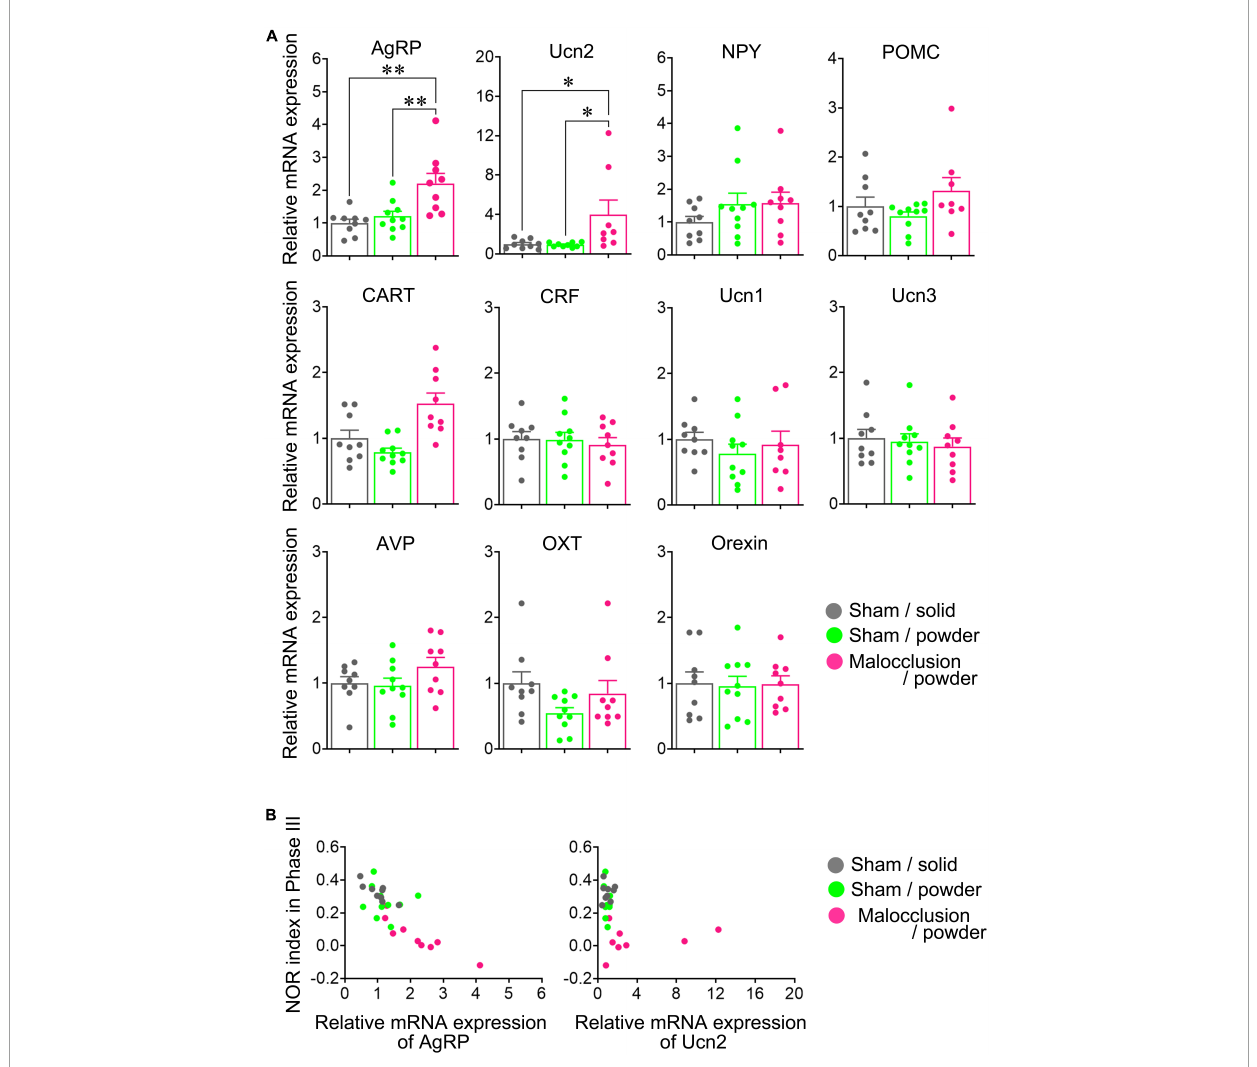
FIGURE3 Hypothalamic neuropeptide mRNA levels. (A) mRNA levels of AgRP, agouti-related peptide; NPY, neuropeptide Y; POMC, proopiomelanocortin; CART, cocaine- and amphetamine-regulated transcript; CRF, corticotropin-releasing factor; Ucn, urocortin 1, Ucn2, Ucn3; AVP, arginine vasopressin; OXT, oxytocin, and orexin were measured in hypothalami isolated on Day 30. (B) Correlation between mRNA expressions of AgRP or Ucn2 and Phase III NOR indices are represented with respective Pearson correlation coefficients. Data are represented as means ± SEM ( n = 8–10). Differences were considered significant at * p < 0.05 and ** p <